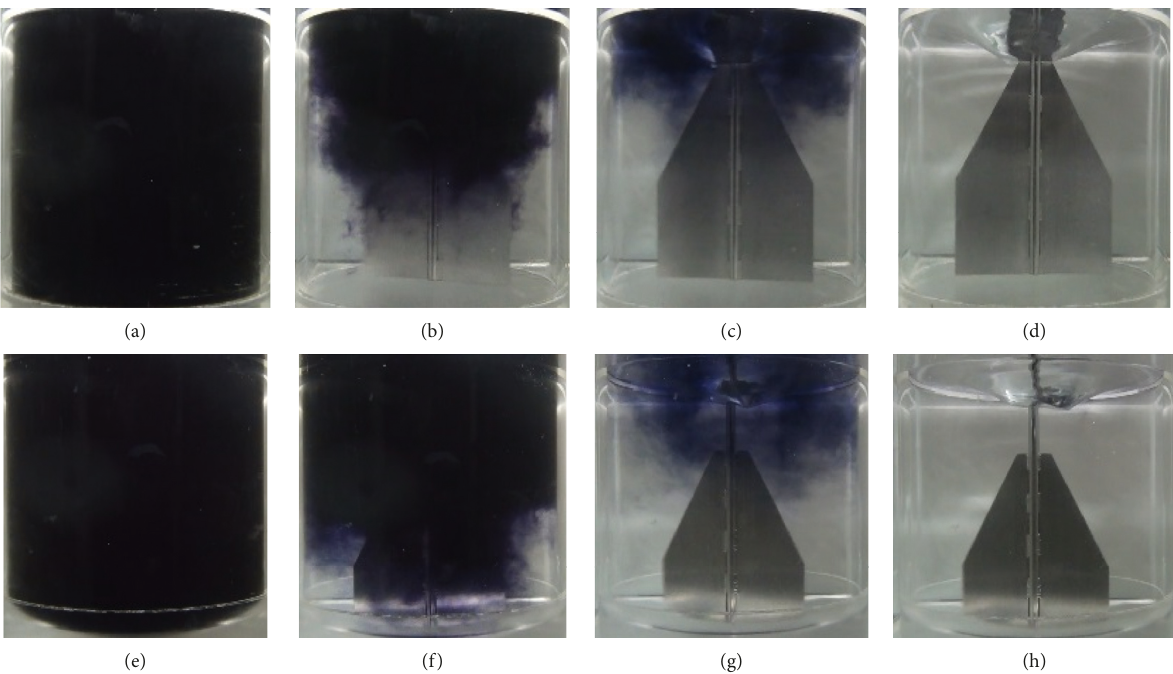
Figure 7: Mixing process at Re � 23,000 of HB impellers with a flat bottom ((a) 0 s, (b) 5 s, (c) 8s, and (d) 10s) and a dished bottom ((e) 0s,